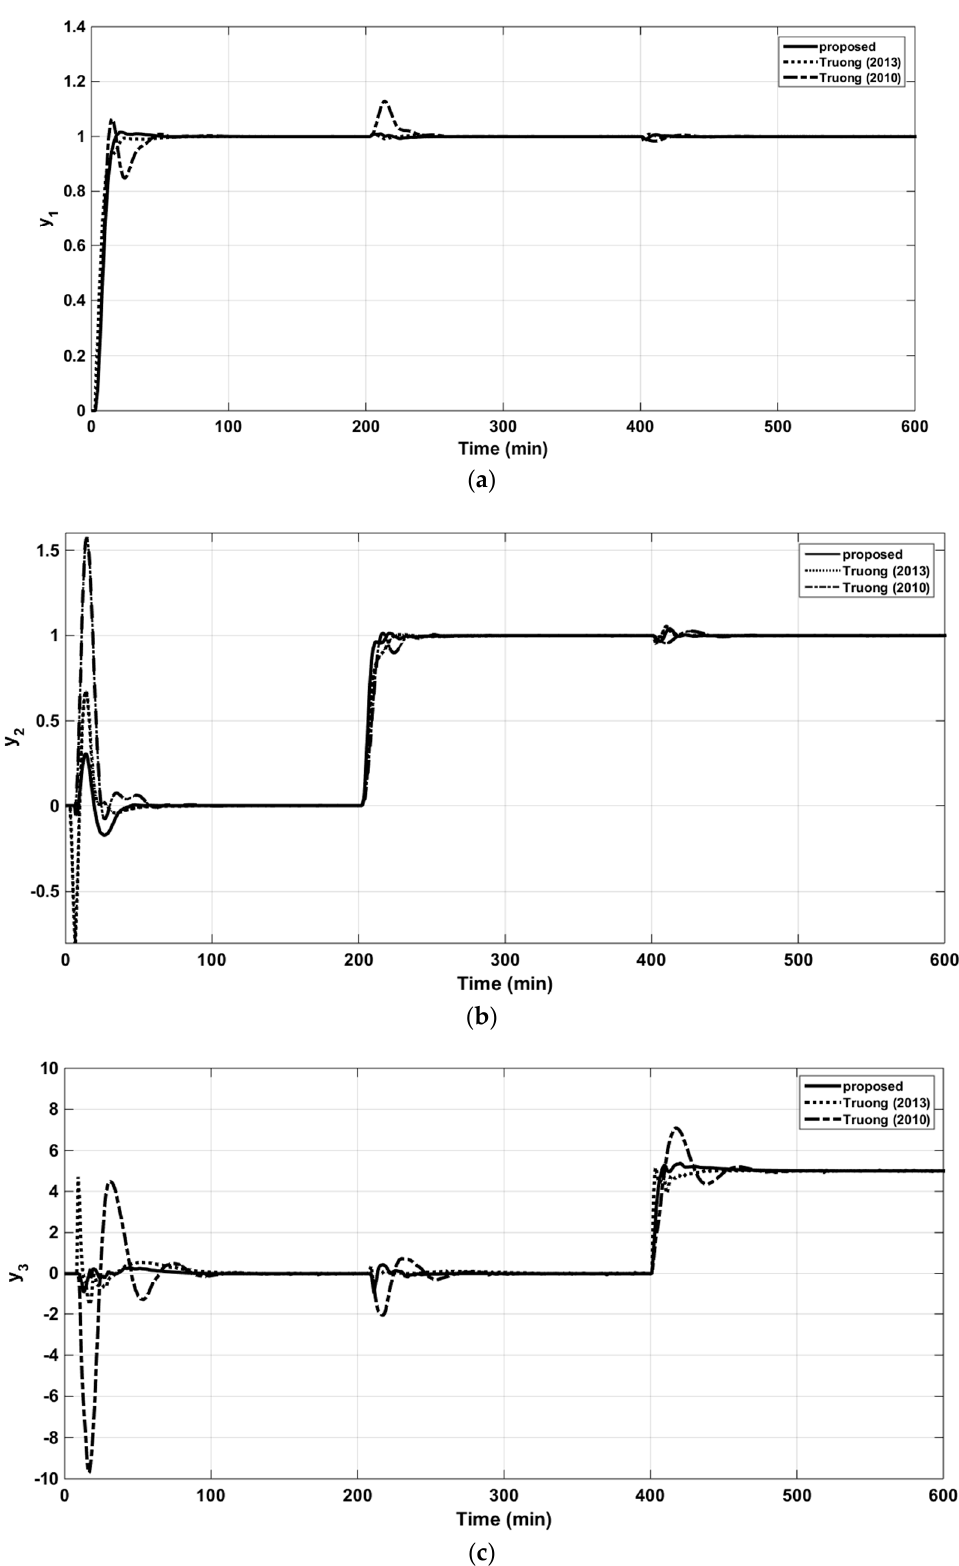
Figure 21. Closed-loop responses to the unit step changes in the set-point of loop 1 (OR column) ( a ). Closed-loop responses to the unit step changes in the set-point of loop 2 (OR column) ( b ). Closed-loop responses to the unit step changes in the set-point of loop 3 (OR column) ( c ).